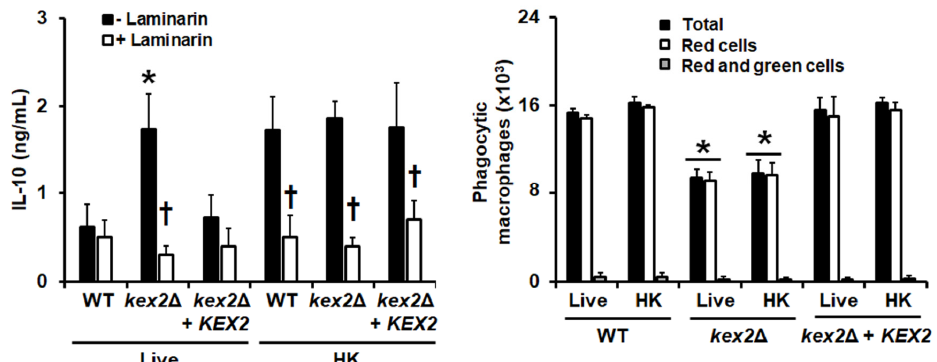
Figure 5. The interaction of Candida albicans with monocyte-derived macrophages is affected by the loss of Kex2. In the left panel , live or heat-killed (HK) yeast cells and human monocyte-derived macrophages were co-incubated for 2 h, the supernatant saved and used to quantify IL-10. In the right panel , before the cell–cell interaction, the yeast cells were labeled with 1 mg/mL Acridine orange and after the 2 h incubation, the human cells were analyzed by flow cytometry as described in the Materials and Methods section. Total refers to the total number of macrophages phagocytosing at least one yeast cell, red cells and red and green cells are regarded as yeast cells in the late and intermediate stages of the phagocytosis process, respectively. For both panels, Results (means ± SD) were obtained using samples from eight donors, each assayed in duplicate wells. * P < 0.05, when compared with WT or reintegrant control cells under the same treatment; † P < 0.05, when compared with cells without preincubation with laminarin. Strains used are NGY152 (WT), HMY209 ( kex2 Δ ), and HMY210 ( kex2 Δ + KEX2 ).